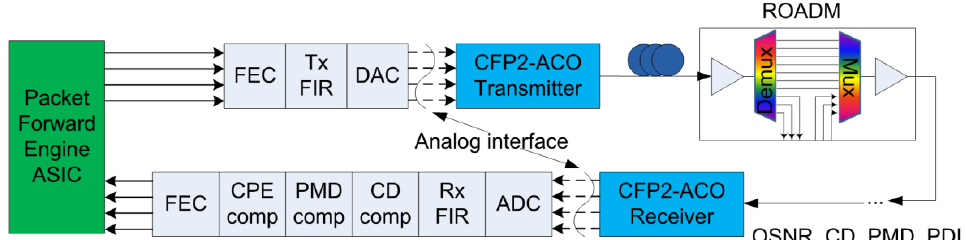
Figure 1. Block diagram of coherent line-card and optical line system. FEC: forward error correction, CPE: carrier phase estimation. Network management layer is not shown for simplicity.